Question: Provide a one-line summary of what is displayed.
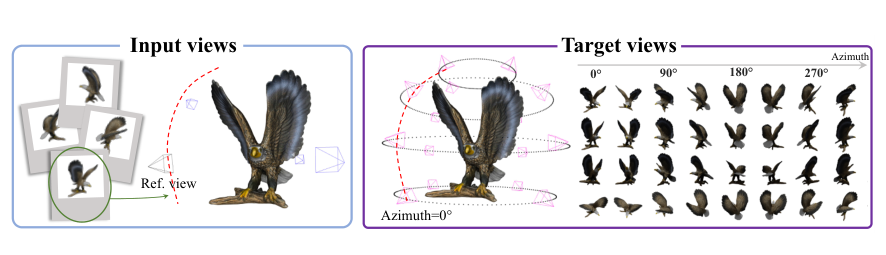
Answer: The input and output specification (§4.1) of MVDiffusion++. The 32 target images are defined in eight azimuths and four elevation levels. During training, our view dropout strategy (§4.3) randomly drops a substantial number of views (dashed blue) and trains the model to denoise the remaining views (red).